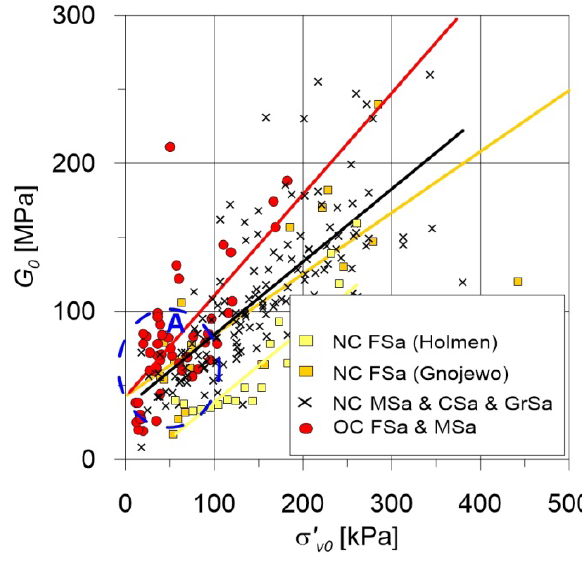
and the vertical stress ( s ’ ) 0 v0